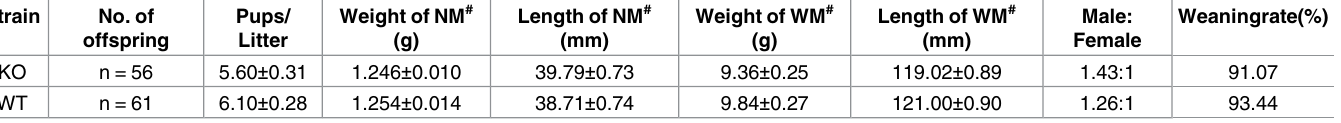
Note # NM = neonatal mice; WM = weaned mice; the values represent the mean ± standard deviation. One-way analysis of variance and pairwise comparison were performed; and P > 0.05 indicates no significant change compared with the control.